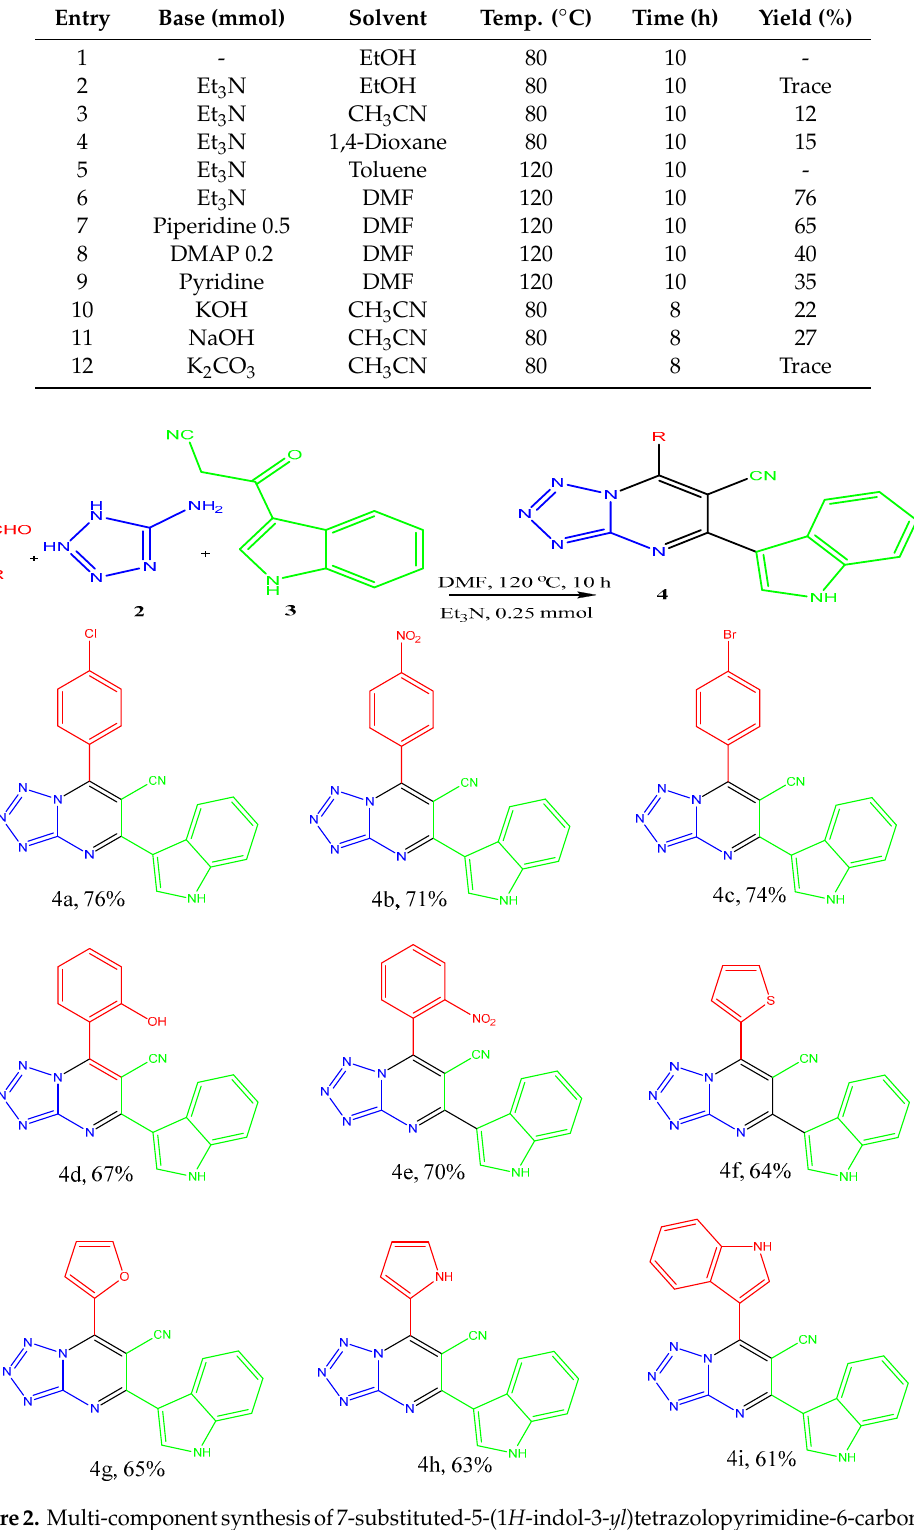
Table 1. Optimization of the multicomponent reactions (MCRs) between 4-choloro benzaldehyde,